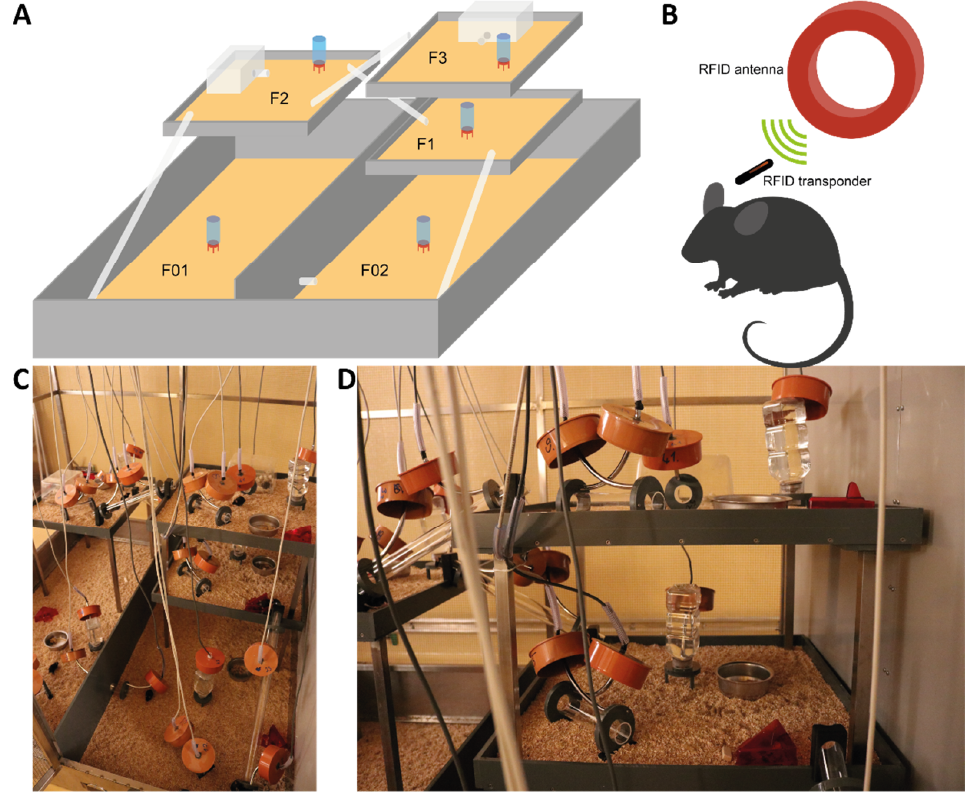
Figure 1. ( A ) Semi naturalistic environment (SNE) divided into five different levels (F01–F3). ( B ) Schematic illustration of the principle of tracking the mice through the RFID antennas. ( C ) Picture of the entire cage interior. ( D ) Zoomed in picture of the attachment of the antennas to enrichment tubes, drinking bottles and connecting tubes.